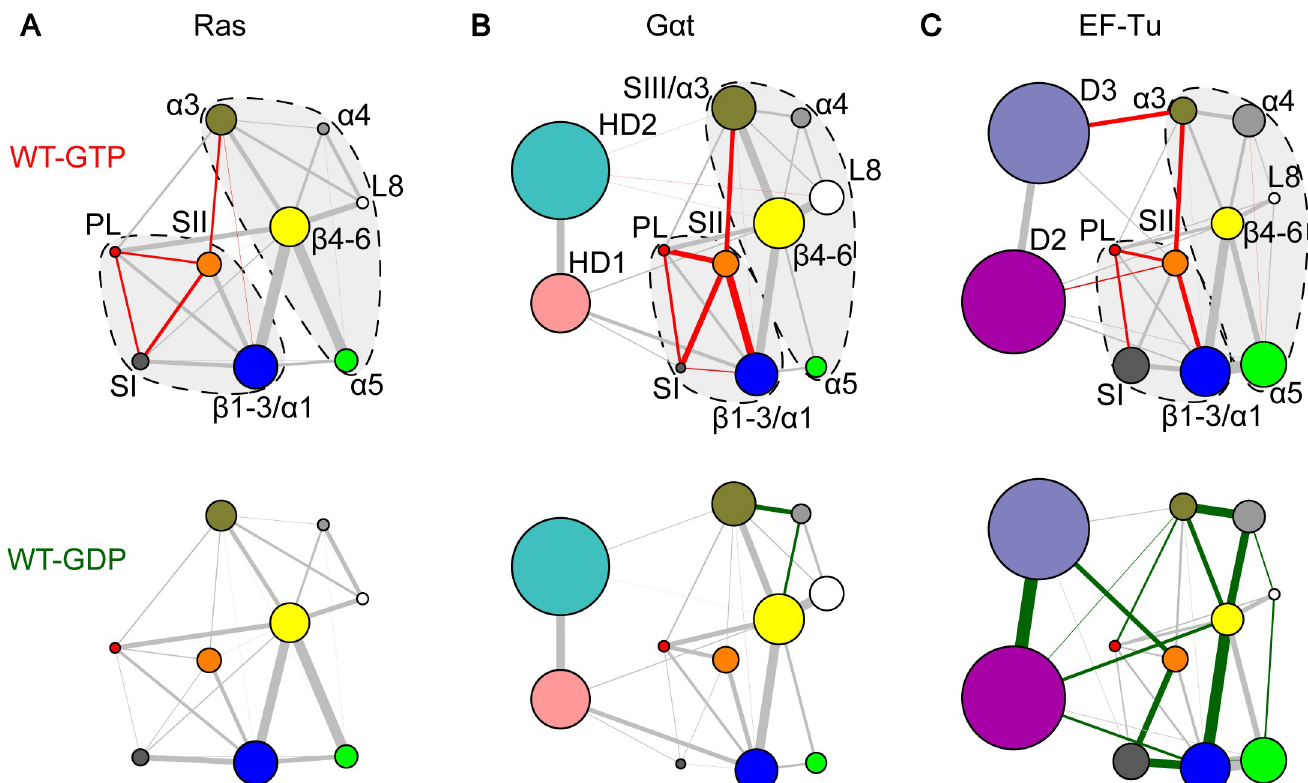
Fig 4. Correlation network analysis reveals similar patterns of nucleotide-dependent couplings in Ras, G α t and EF-Tu. ( A ) Network communities are represented as colored circles with different radius indicating the number of residues within the community. The width of an edge is determined by the summation of all residue level correlation values between two connected communities. Red and green edges indicate enhanced GTP or GDP couplings that are significantly ( p - value < 0.05) or more than two-fold stronger in one state than the other. All other lines are colored gray. Dashed lines with a light gray background represent the two-lobe substructures. ( B & C ) Similar nucleotide-associated network patterns are evident in the GTP (top) and GDP (bottom) bound state of G α t ( B ) and EF-Tu ( C ), except for the SI and SII coupling.